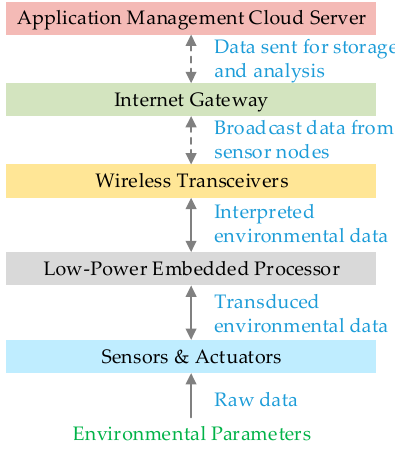
Figure 1. Architecture and information flow in an IoT system [10].